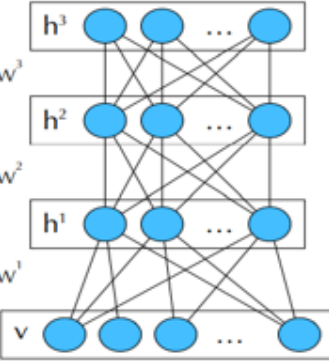
Figure 4. Cumulative accuracy vs. no. of features.